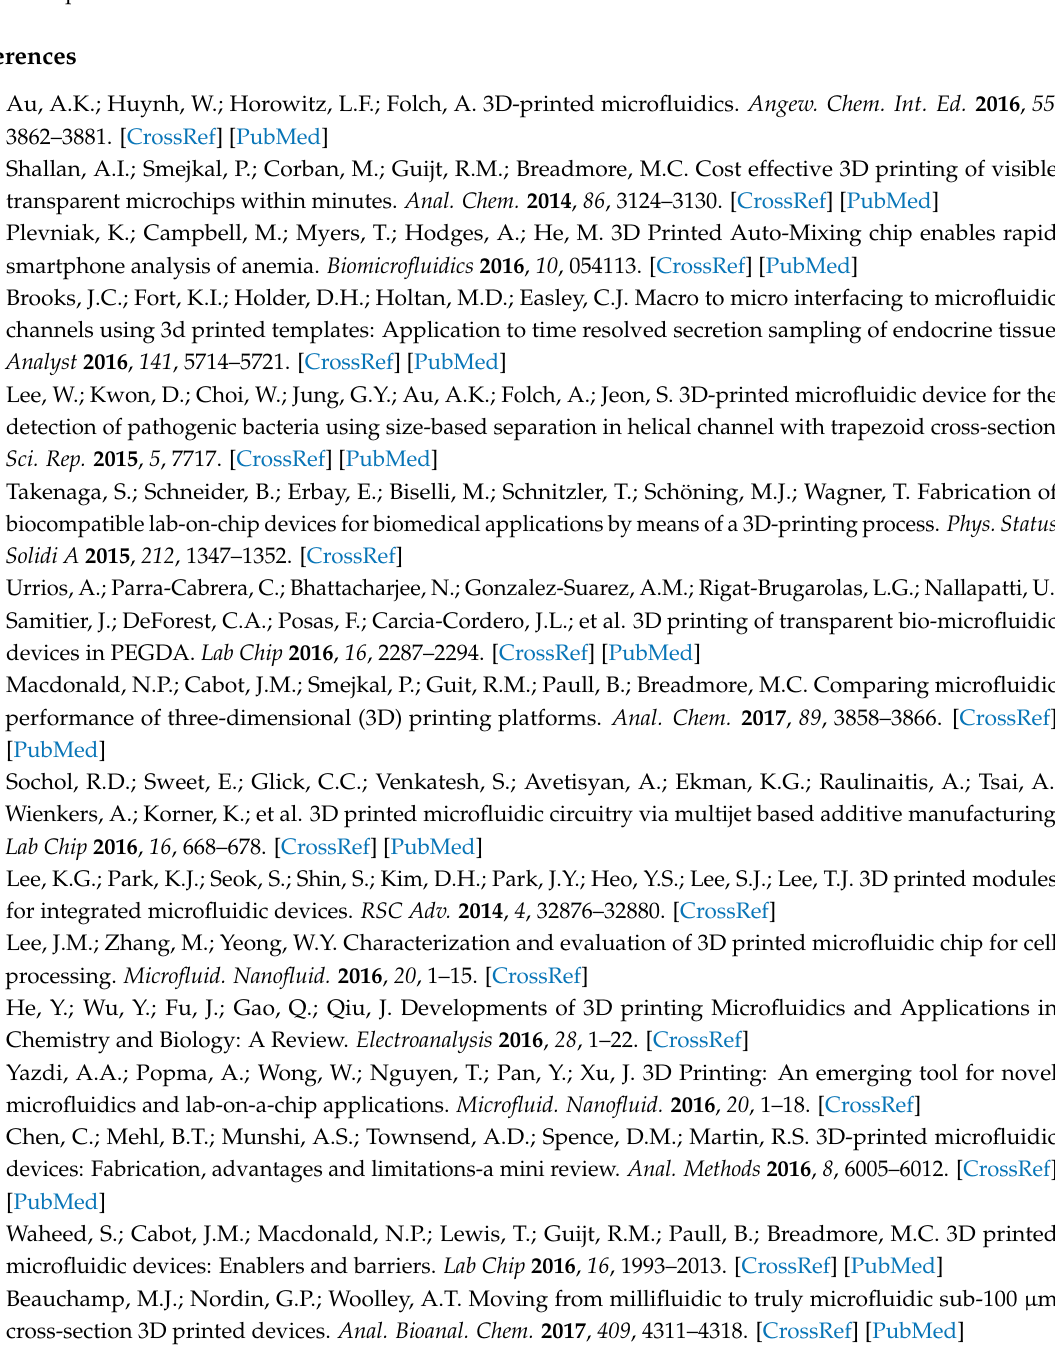
1000 ms; Figure S18: interior features, trenches without edge compensation, 1500 ms; Figure S19: interior features, pillars, 500 ms; Figure S20: interior features, pillars, 1000 ms; Figure S21: interior features, pillars, 1500